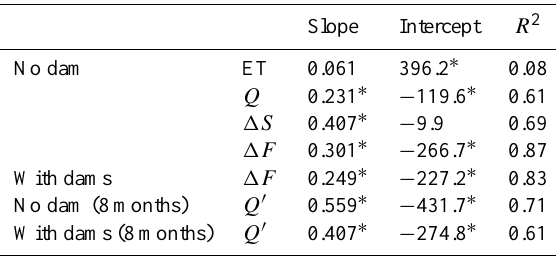
Table 4. Parameters of the regression analysis with 6-month cumu- lative rainfall in Figs. 7 and